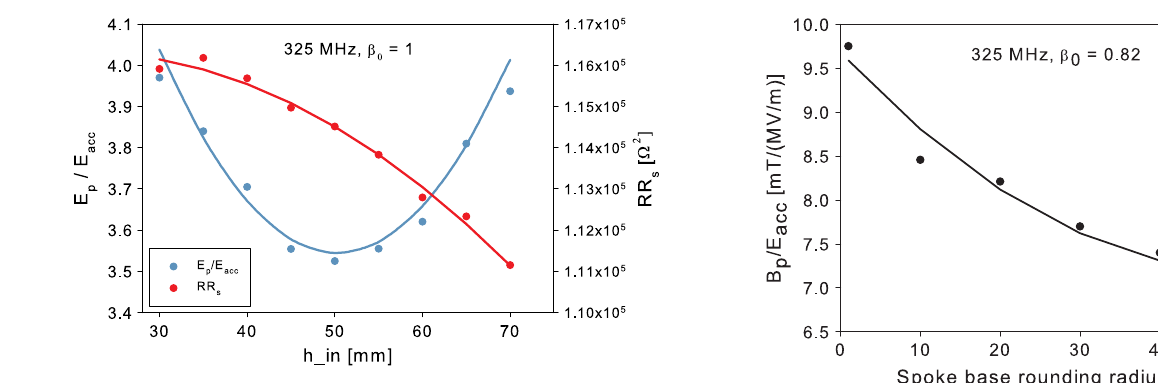
FIG. 33. Dependence of B p =E acc on the spoke base rounding